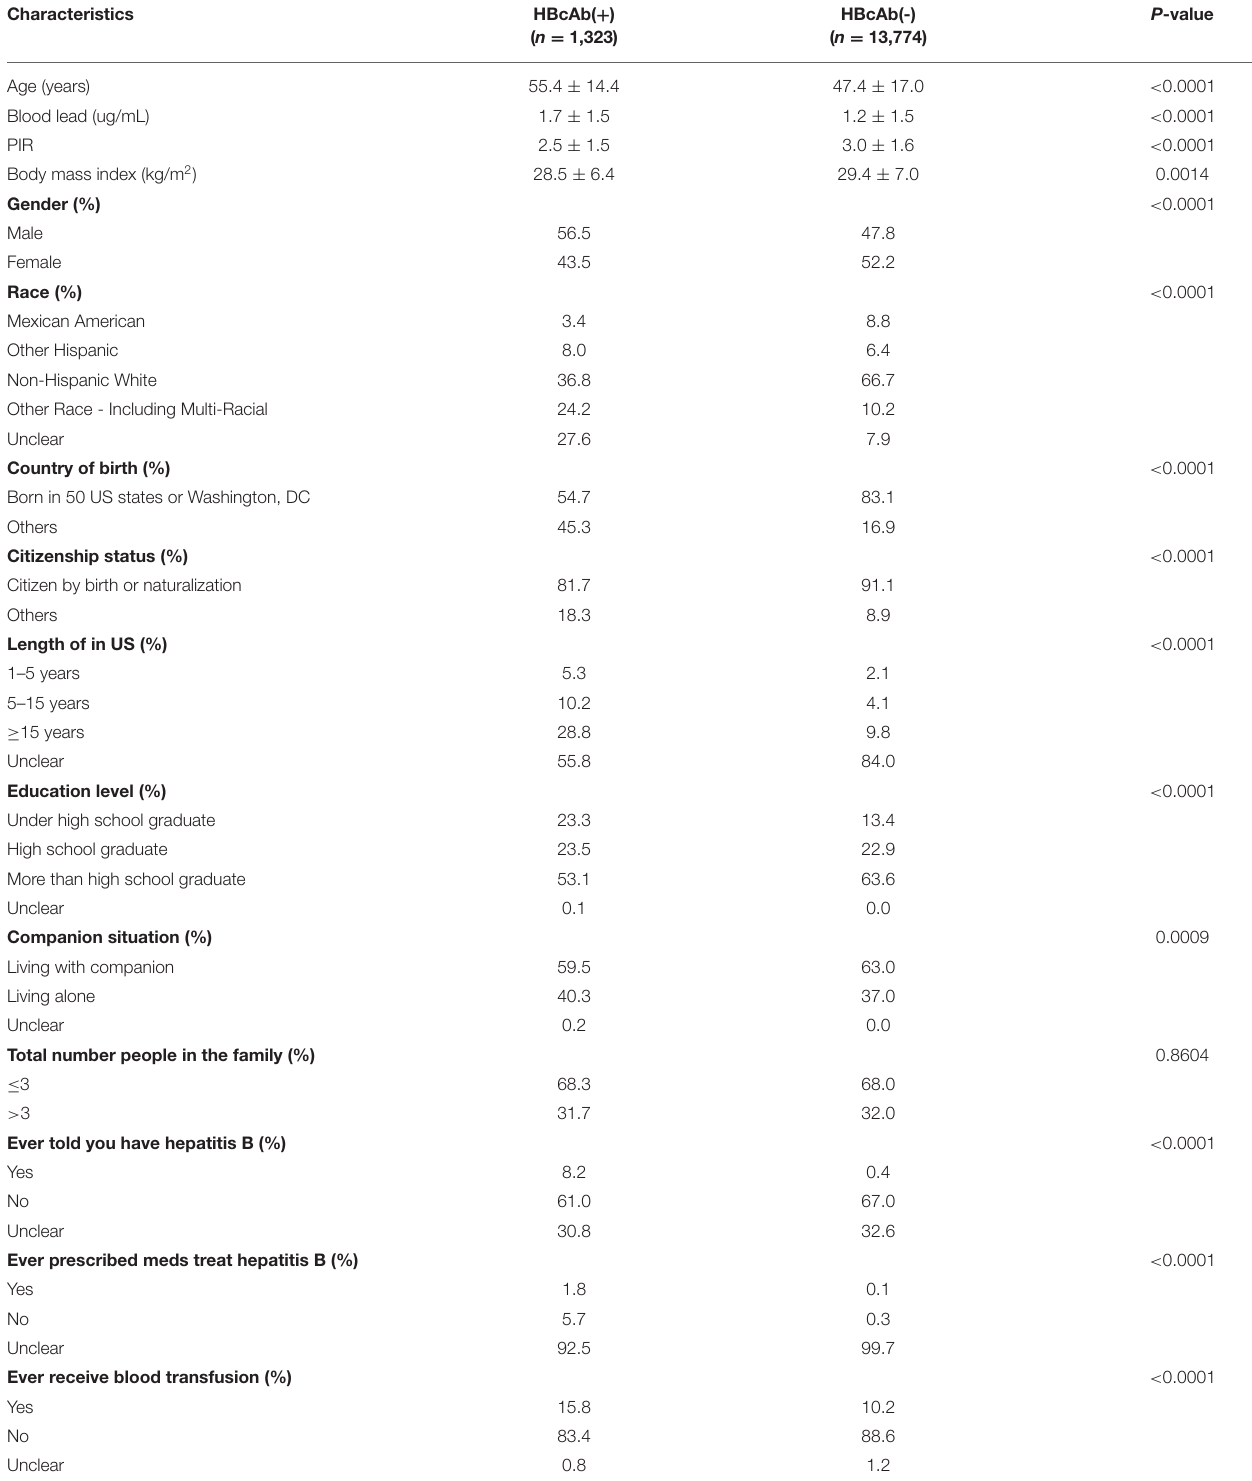
TABLE 1 | Characteristics of the U.S. participants in national health and nutrition examination survey (NHANES) from 2011 to 2018.